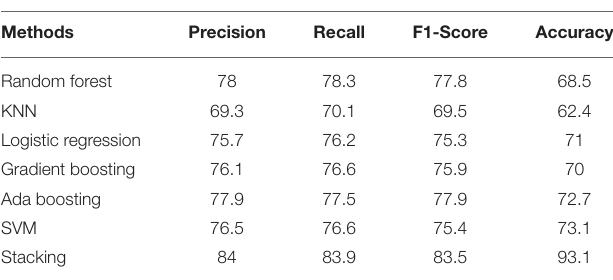
TABLE 5 | Quality metrics